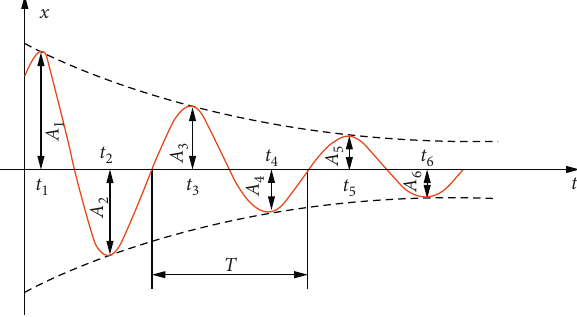
Figure 7: Response curve of free vibration. Table 1: Parameters of the boring bar with a variable stiffness